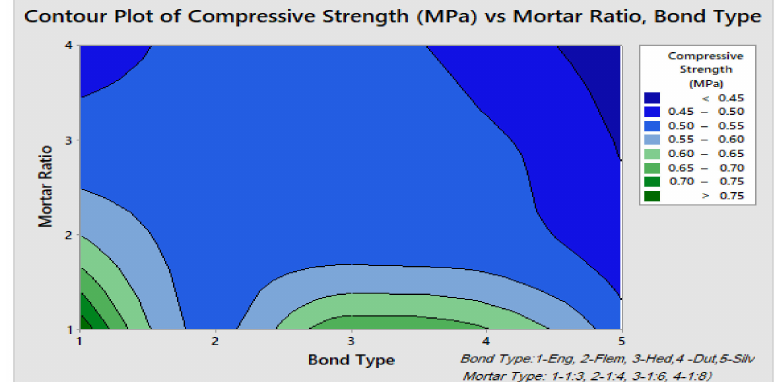
Figure 7. Compressive strength with reference to bond type and mortar ratio.